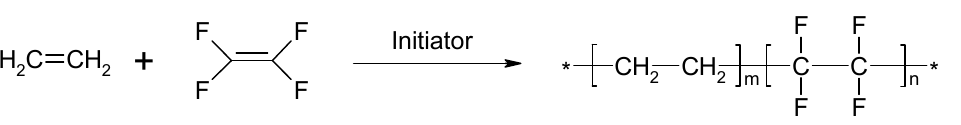
Figure 9. The preparation of